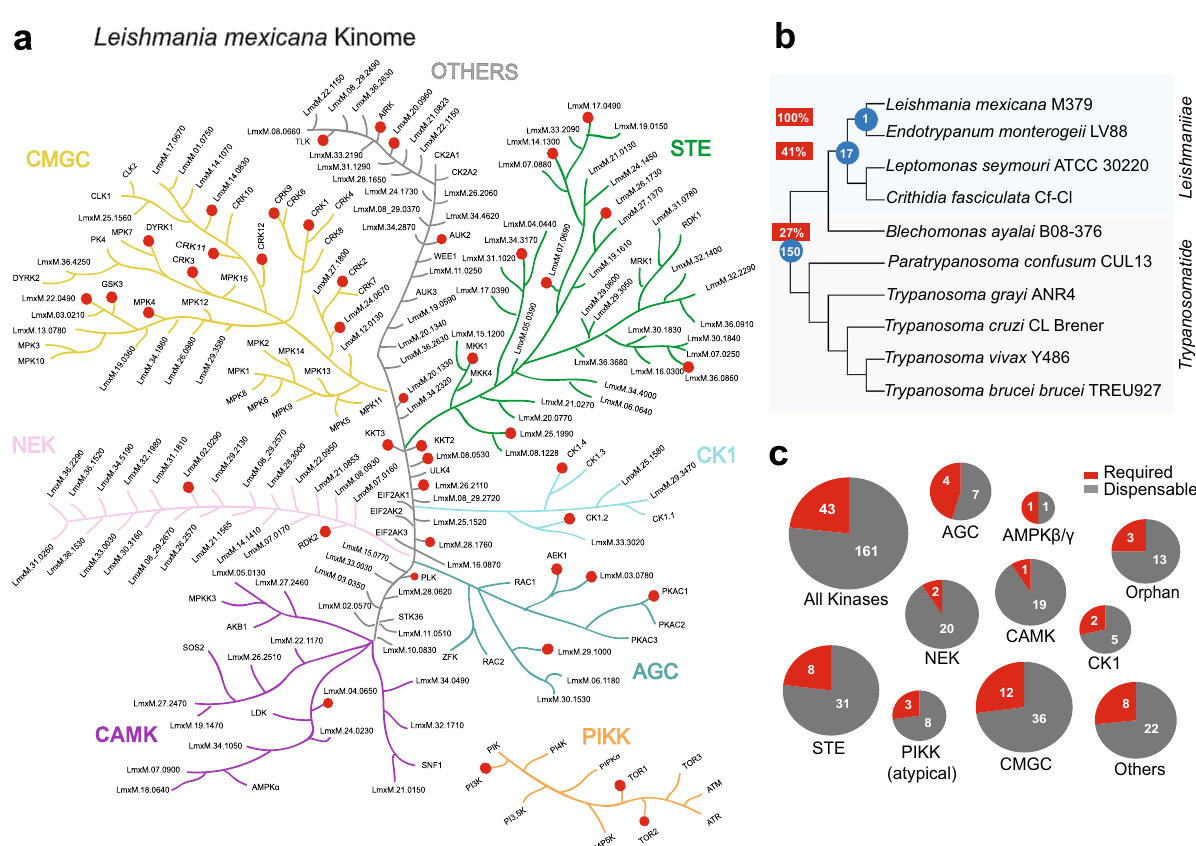
Fig. 1 L. mexicana kinome and conservation in other pathogenic trypanosomatids. a Representation of eukaryotic (ePK) and phosphatidylinositol 3 ′ kinase-related kinases (PIKK) protein kinase families, separated by colours de fi ned by primary protein sequence conservation. Image for illustrative purpose only with no phylogenetic signi fi cance. Red dots represent protein kinases for which gene deletion mutants could not be generated and are therefore potentially essential genes in procyclic promastigotes. b Phylogenetic tree of trypanosomatids with the number of orthologous protein kinases unique to each node indicated by blue circles and the percentage of potentially essential orthologous protein kinases unique to each node indicated within a red rectangle. c Pie-charts show dispensable (non-essential) and required (potentially essential) protein kinases in procyclic promastigotes, separated into